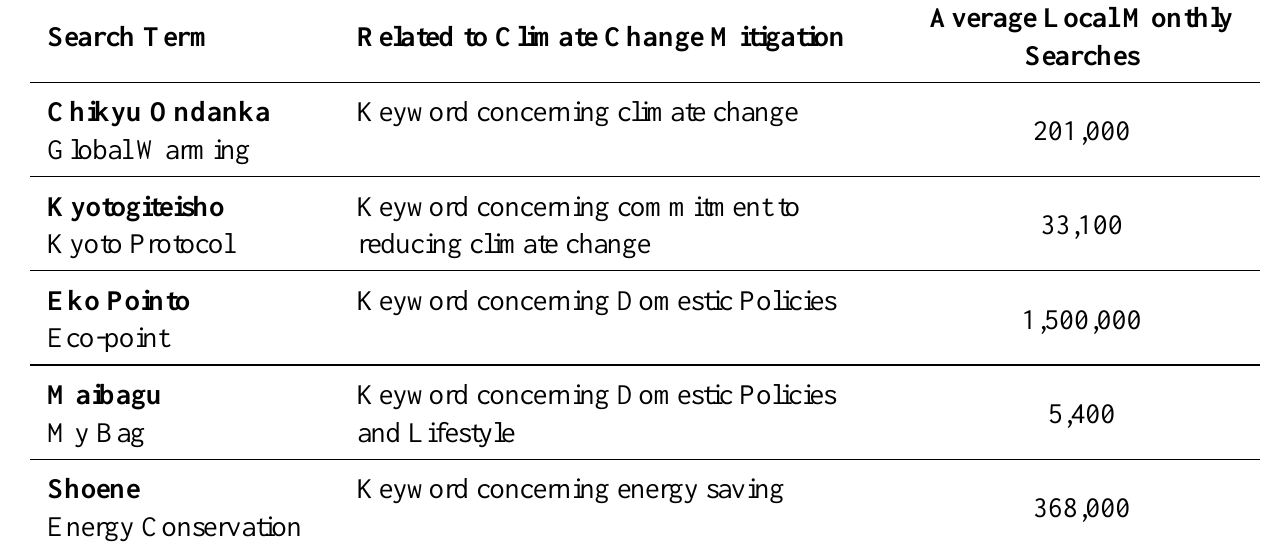
Table 1. Search terms and related search volumes in June